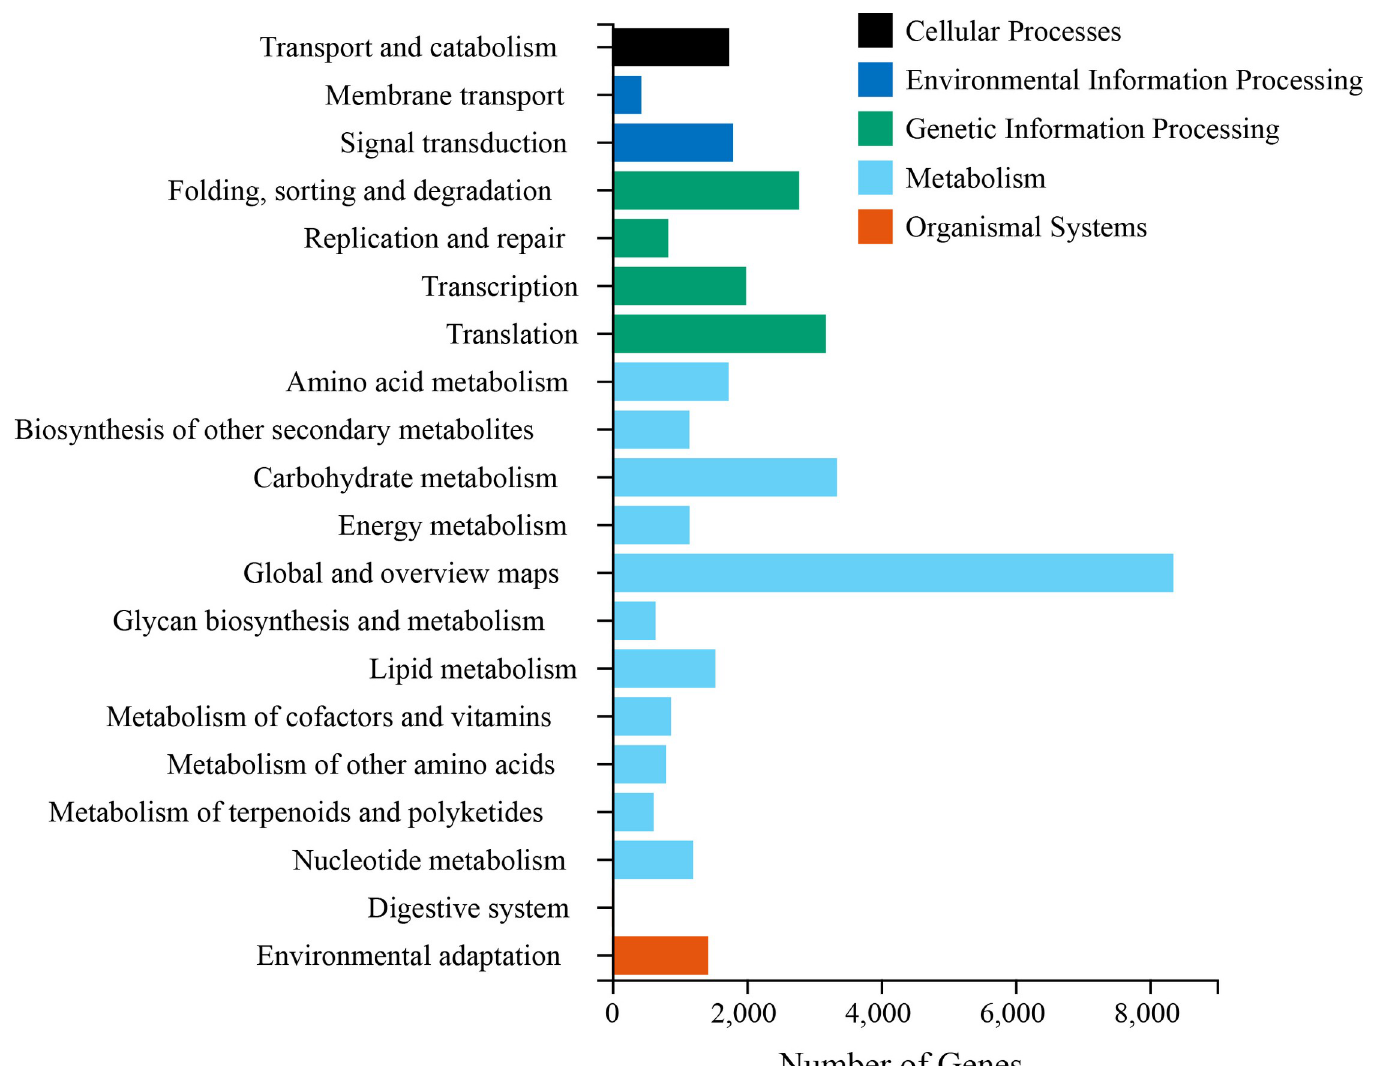
Fig 5. Functional annotations and classifications of unigenes in KEGG databases. KEGG analysis was performed at level 2 for five main categories (cellular processes, environmental information processing, genetic information processing, metabolism and organismal